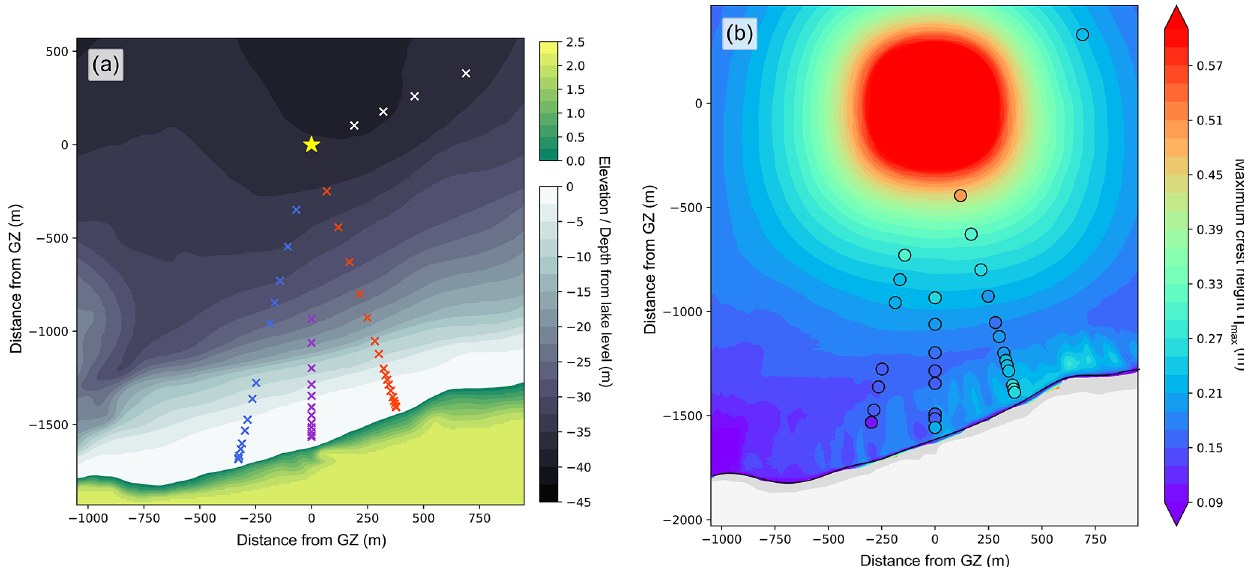
Figure 6. (a) Setting of test series on the south of Mono Lake with bathymetry and near-shore terrain elevation. The yellow star marks ground zero (GZ), and crosses mark gauge locations. Gauge radials are coloured by red (one), purple (two), blue (three), and white (four). (b) Numerical results of maximum crest amplitude for Shot 3 are overlaid by observed maximum crest amplitudes at gauge